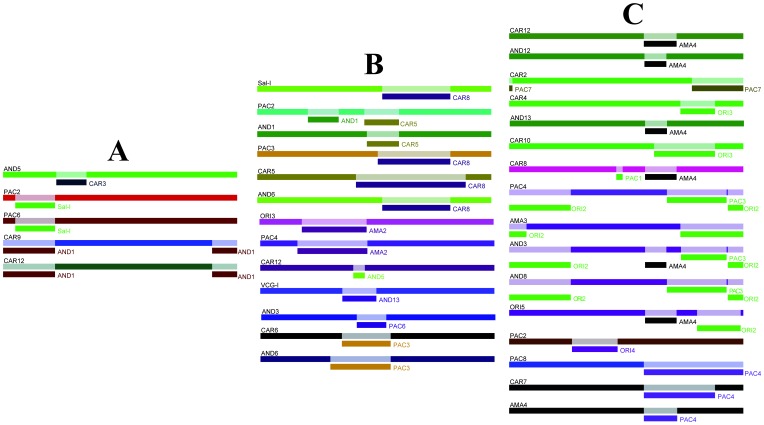
Schematic representation of recombination fragments identified by RDP3 v.3.4 for Pvmsp-7C (A), Pvmsp-7H (B) and Pvmsp-7I (C).The sequence names in black above the rectangles indicate the name of recombinant sequence. The rectangle with name to the right (name of the close relative minor parent) shown in different colors is a graphical representation of a sequence fragment that has potentially been derived through recombination. Only recombination events having p<0.03 were taken into account. SAL-I: Salvador strain, AMA: Amazonian, AND: Andean, CAR: Caribbean, ORI: Orinoco, PAC: Pacific.